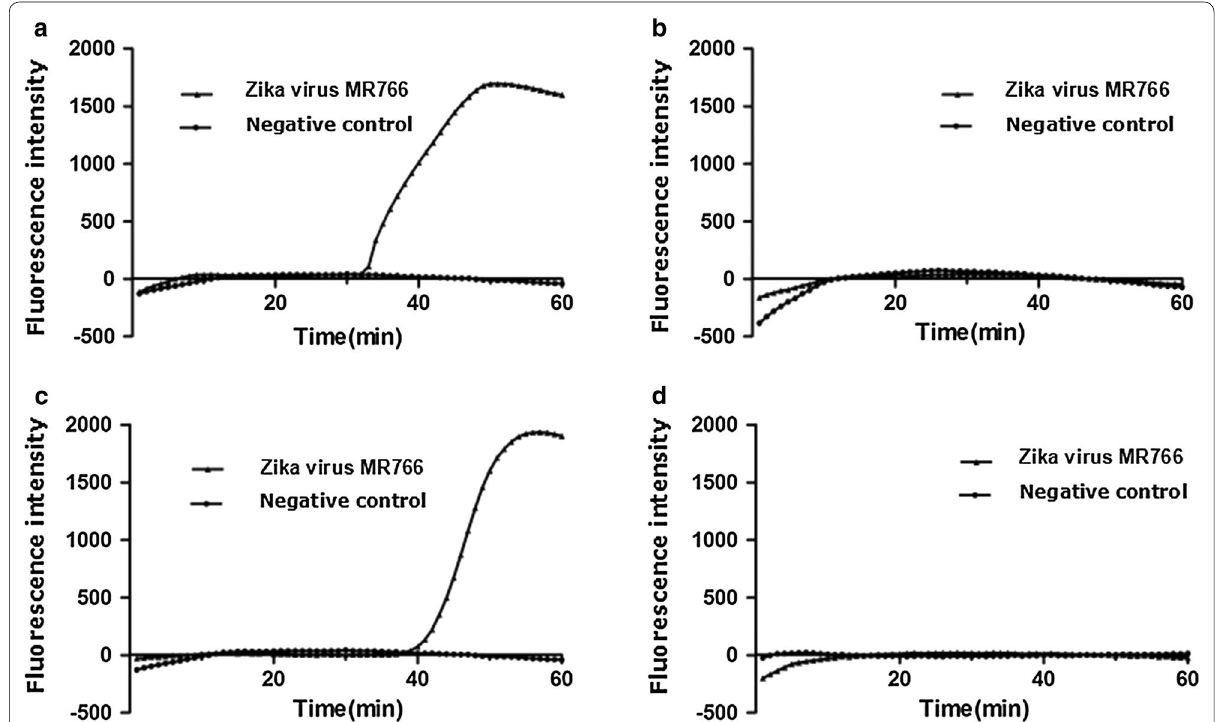
Fig. 1 The primer of the LAMP screening test in this study: a real‑amp without loop primers (NS5‑1); b real‑amp without loop primers (NS5‑2); c real‑amp without loop primers (NS5‑3); d real‑amp without loop primers